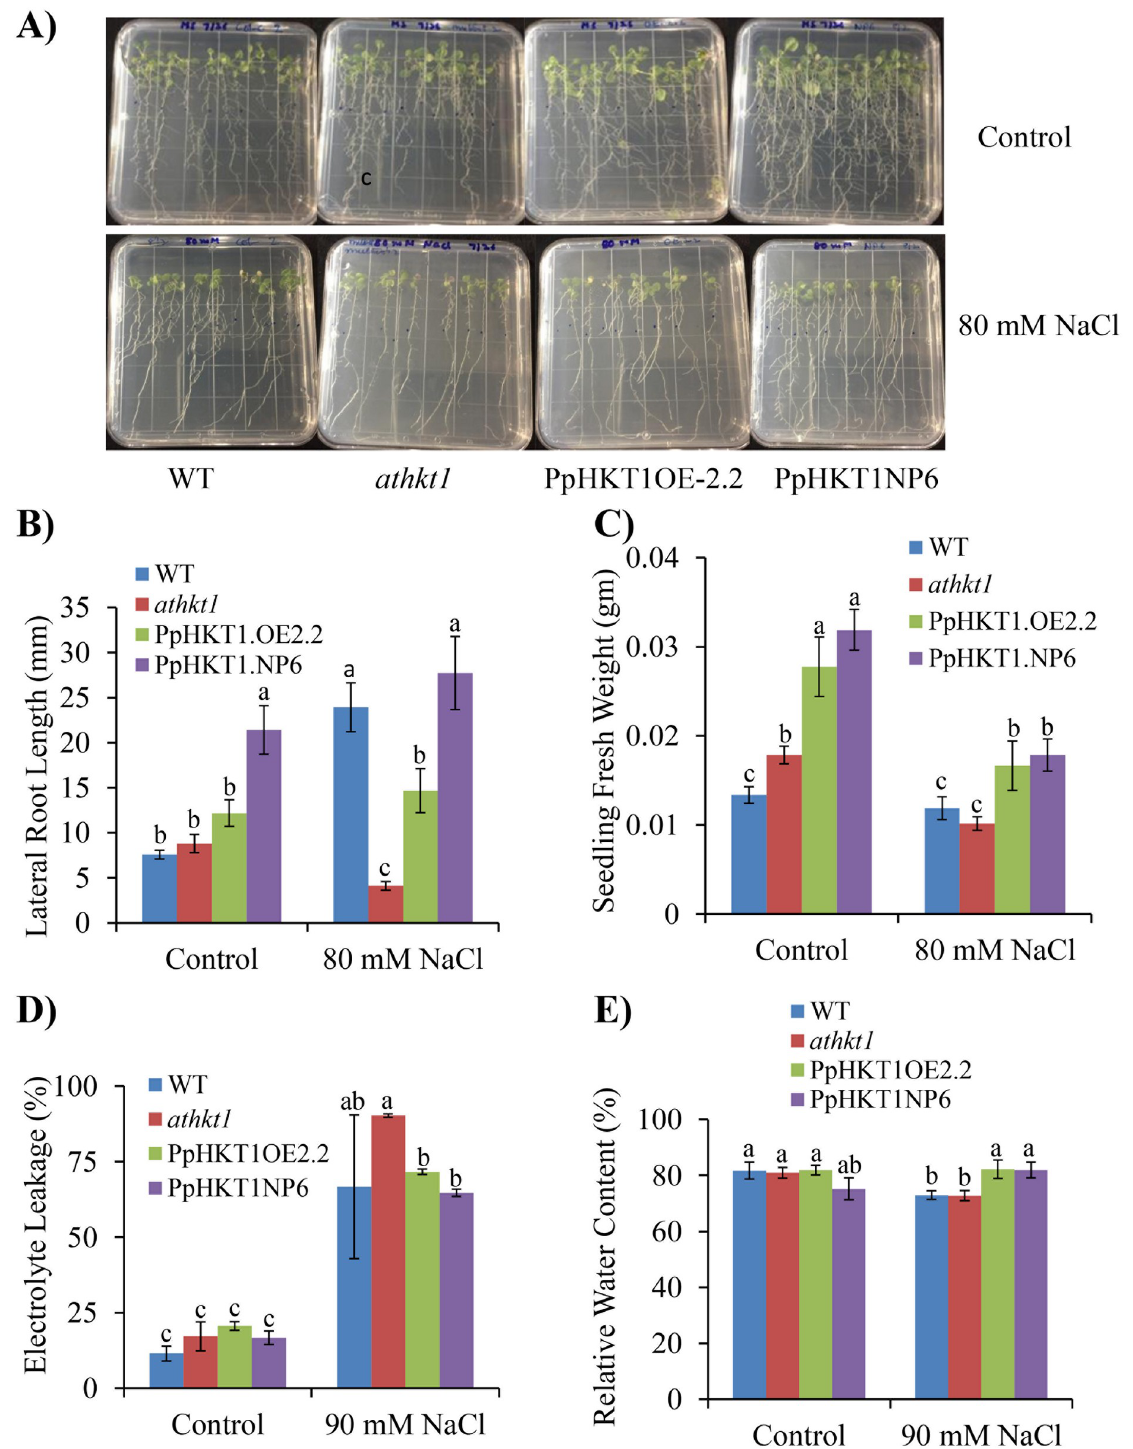
Fig 3. Different salinity stress tolerance parameters evaluated in WT, athkt1 and the transgenic lines. A) Lateral root growth assay. Arabidopsis lines were exposed to 80 mM NaCl and pictured 10 days after treatment. B) Average lateral root length calculated by Image J software. C) Seedling average fresh weight after 10 days under control or 80 mM NaCl, with 10 seedlings per replicate (n = 3). D) Electrolyte leakage calculated 15 days after 90 mM NaCl treatment. E) Relative water content calculated 7 days after 90 mM NaCl treatment. ANOVA single factor was used to depict the statistical differences between athkt1 mutant and each of the transgenic lines. Genotypic means followed by the same letters are not significantly different according to LSD (0.05).